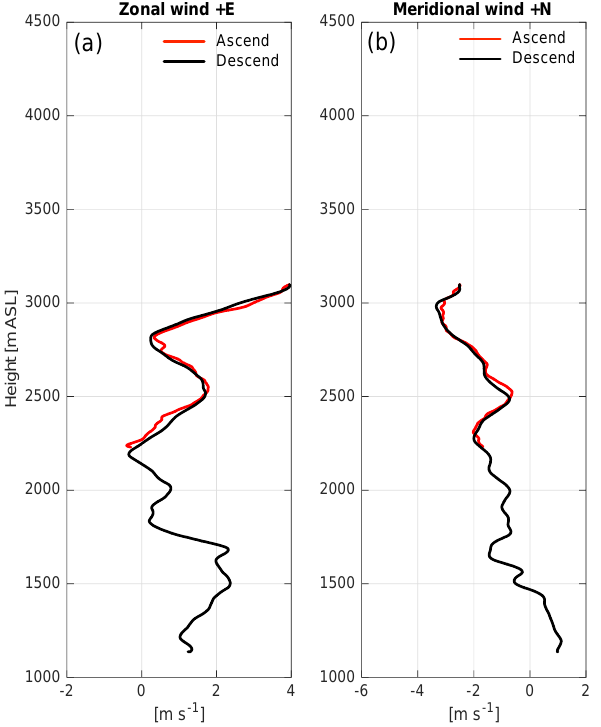
Figure 7. Horizontal winds obtained from the DataHawk for the morning flight. (a) Zonal wind. (b) Meridional wind. The red line indicates the ascent portion of the flight, while the black line indi- cates the descent portion of the